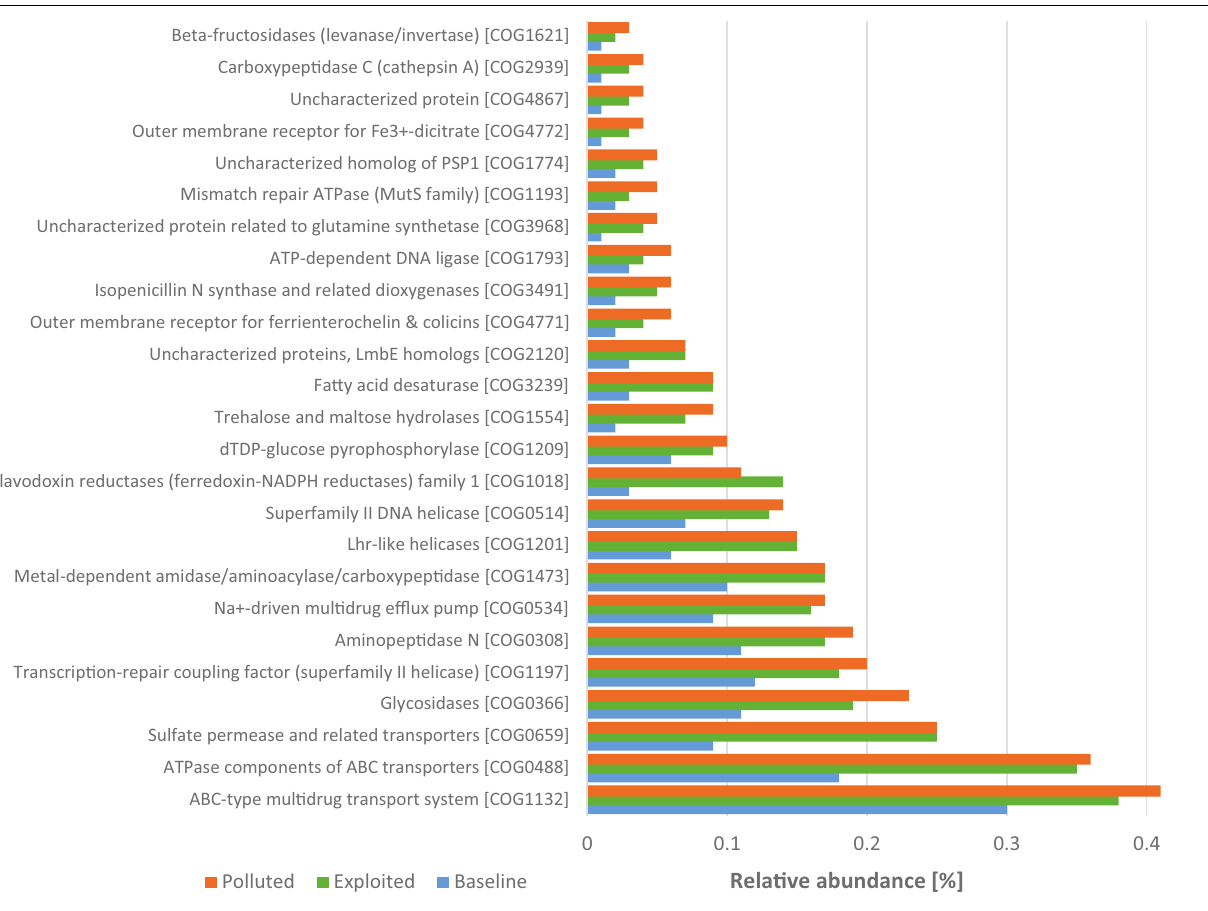
FIGURE 8 | Comparison between Kenya coral reef sites of relative abundances of the 25 most represented COGs that were significantly enriched in the “exploited” and “polluted”